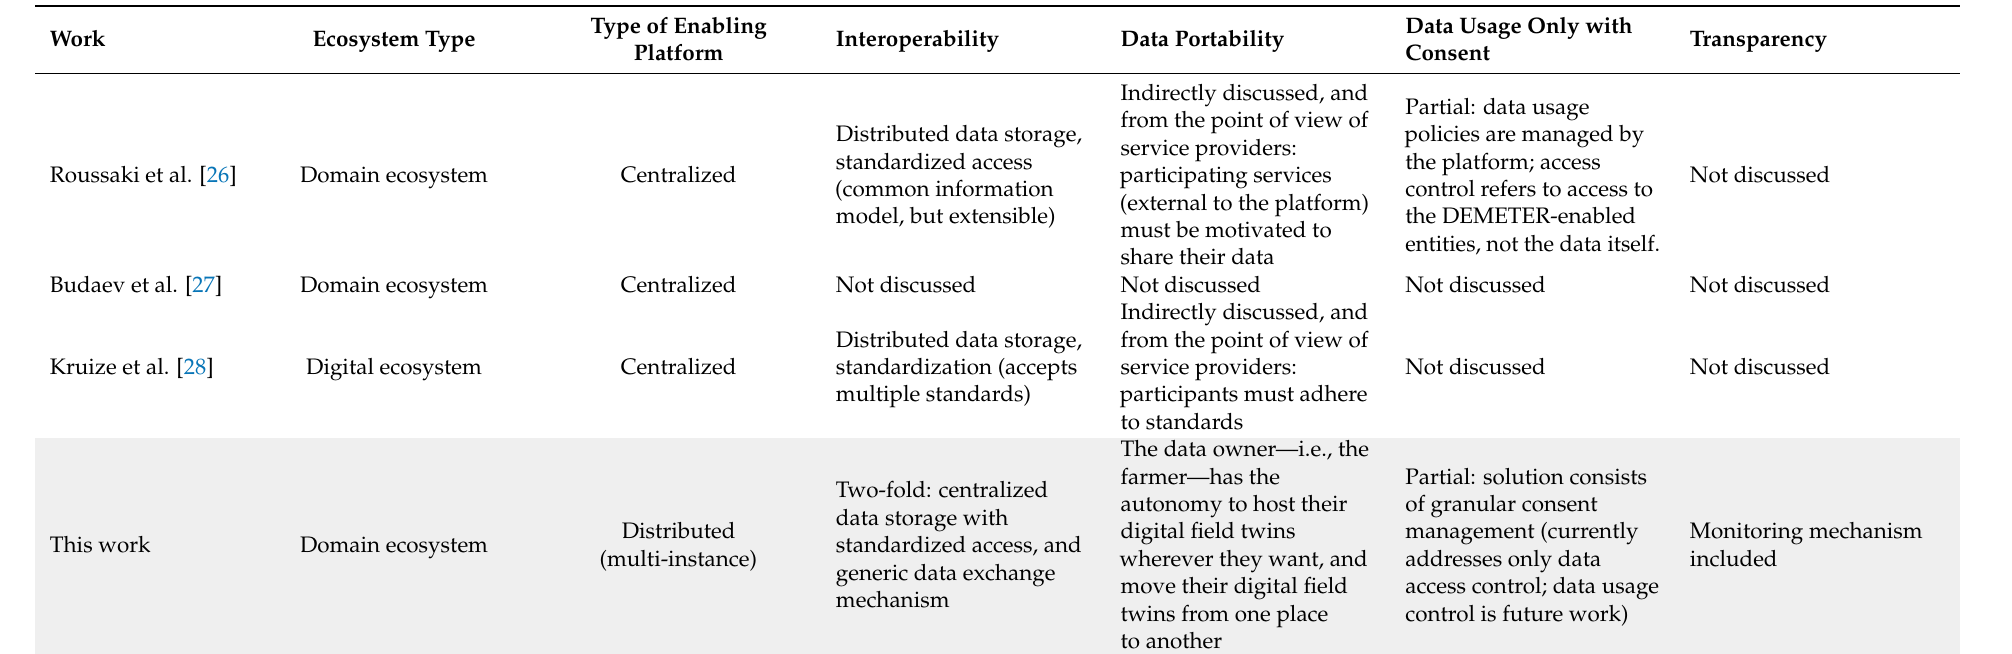
Table 2. Comparison between related work and our reference